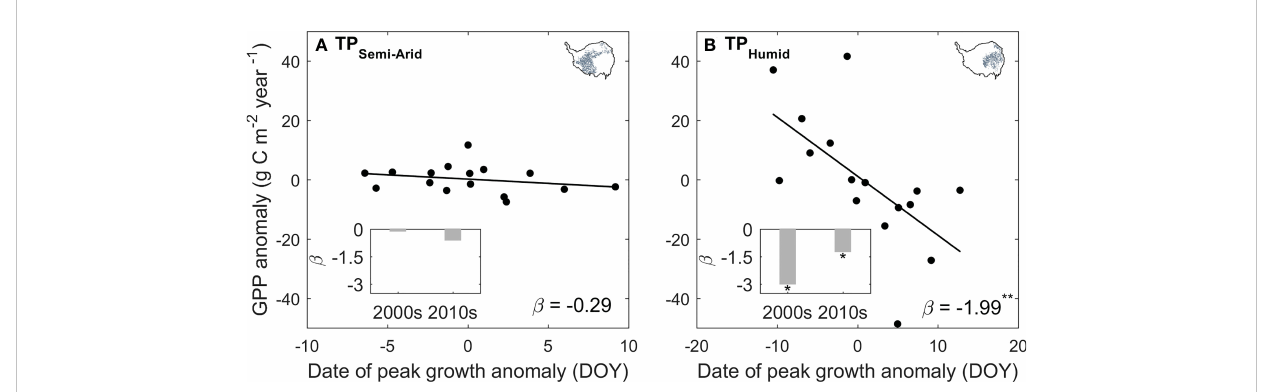
FIGURE 6 The sensitivity of GPP on the changes in the date of peak vegetation growth for the semi-arid western (A) and semi-humid eastern TP (B) . The ß marks the value of the sensitivity, and the marker * and ** indicates statistically signi fi cant at P < 0.1 and P < 0.05 level, respectively. The inset bar plots show the changes in ß between the period 2000s (2001 – 2010) and 2010s (2011 –